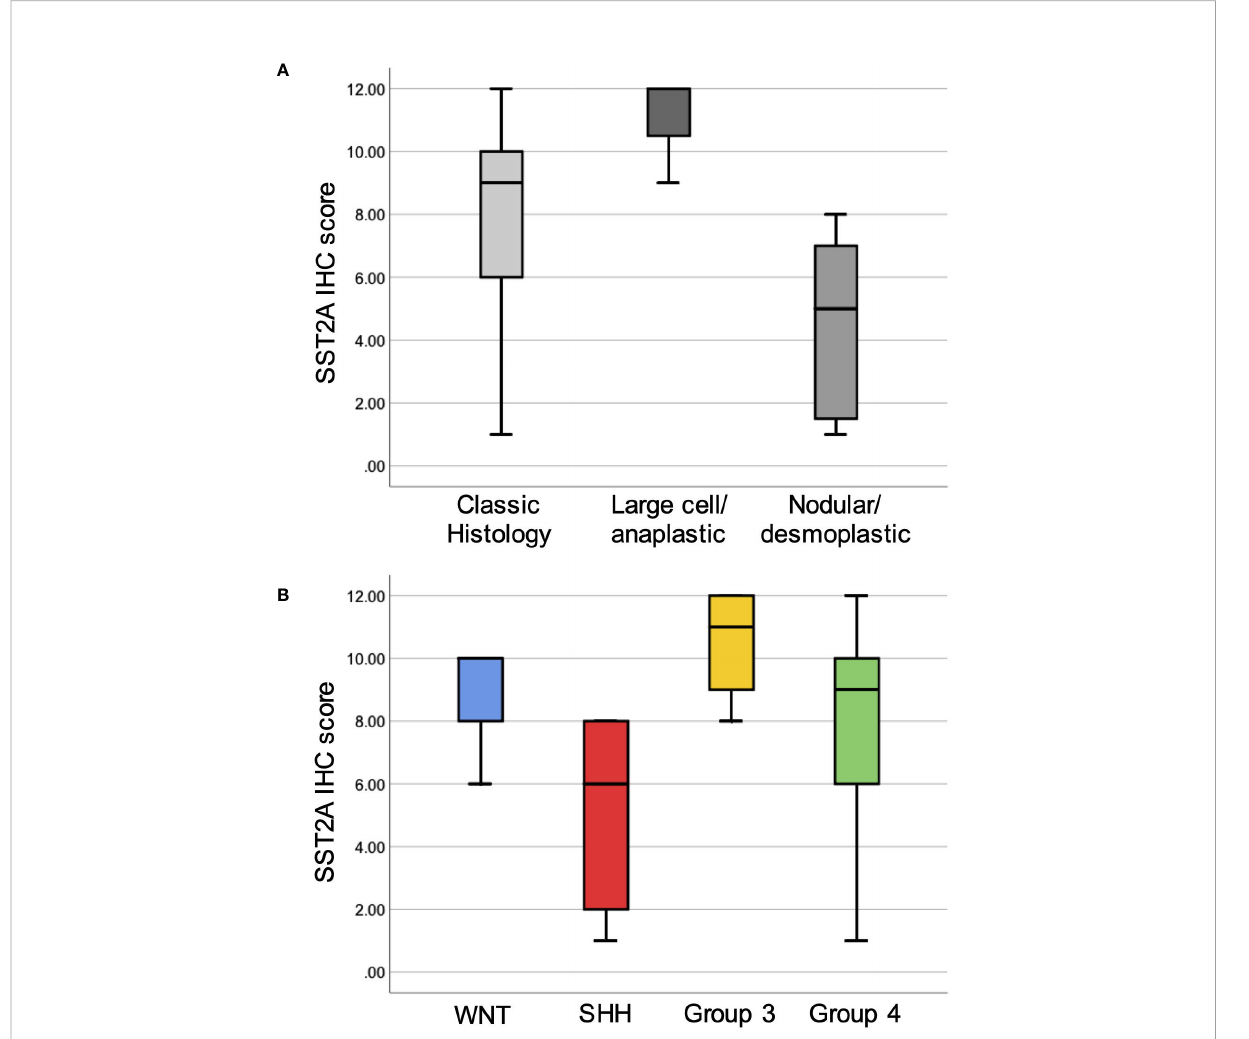
FIGURE 3 Membranous SST2A expression across histopathologic and molecular subgroups of medulloblastoma. Boxplots illustrate total SST2A IHC score by histologic (A) and molecular (B) classi fi